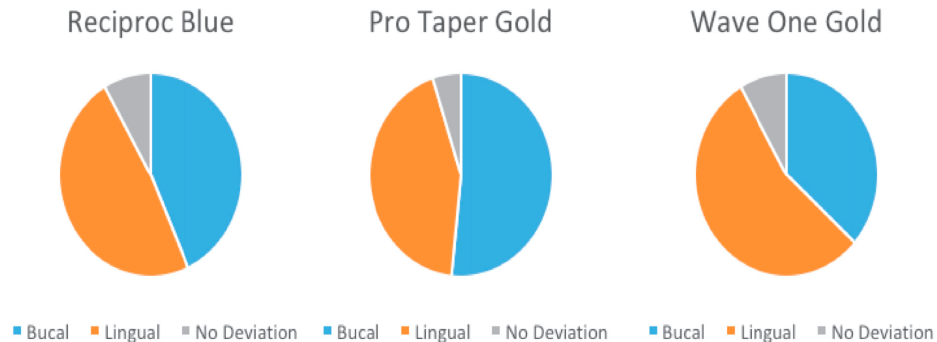
Figure 4. Direction of bucco-lingual transportation for Reciproc Blue, ProTaper Gold, and WaveOne Gold.